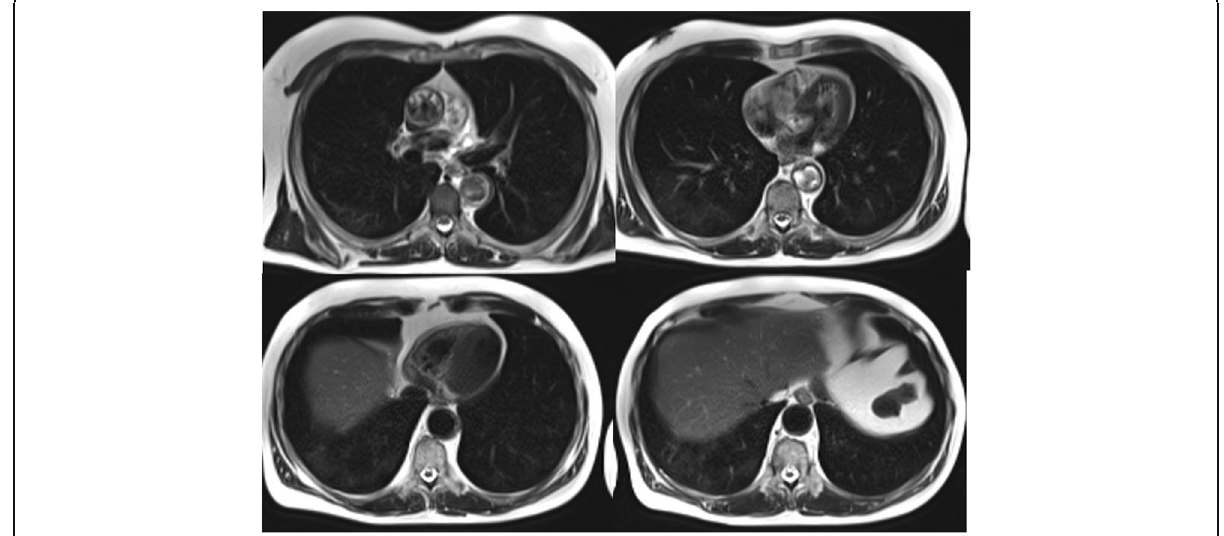
Fig. 1 RM- Whole Body, T2-w sequences on the thorax. There are peripheral thickenings of both